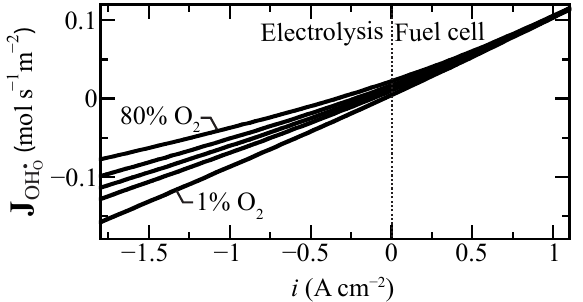
Figure 4. Protonic flux change as a function of current density for selected air side oxygen compo- sitions ranging from 1% to 80% at 600 ◦ C. The oxygen concentration is balanced with steam at the